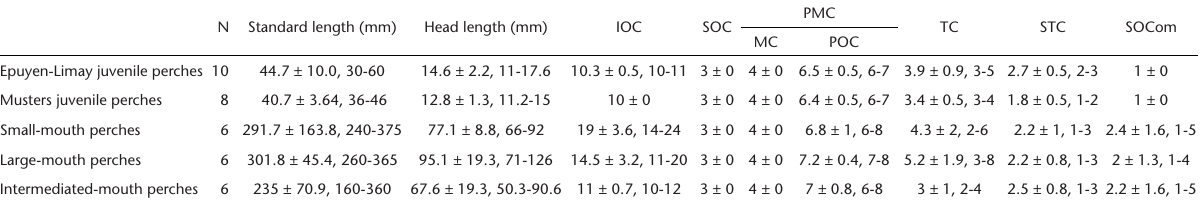
Table 1. Body/head length and the number of pores in cephalic canals (from one side of head) in juveniles and three morphotypes of Percichthys (average ± standard deviation, range